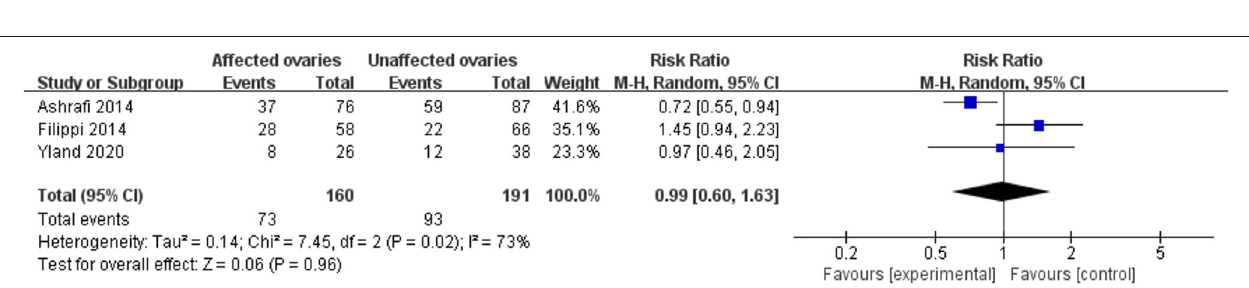
FIGURE 4 | Forest plot of high-quality embryo rate, cleavage rate, and embryo formation rate for stage III-IV endometriosis vs. control.